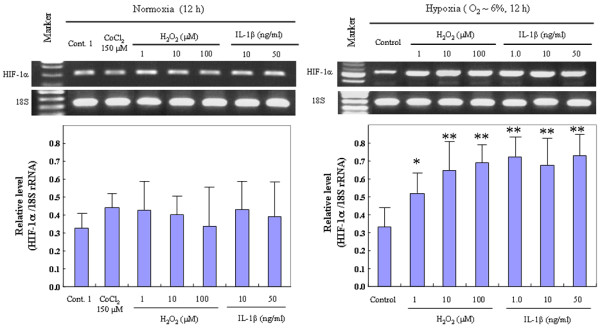
IL-1β and H2O2 induce the expression of HIF-1α mRNA in human articular chondrocytes. Under normoxic culture conditions, mRNA levels of hypoxia-inducible factor 1α (HIF-1α) were observed in cultured chondrocytes, whereas HIF-1α protein was undetected in the cells. HIF-1α mRNA was accelerated by IL-1β or H2O2 in cultured chondrocytes under hypoxic conditions. Cobalt chloride (CoCl2), chemical inducer of HIF-1, was used for the positive control. *P < 0.05, **P < 0.01 compared with the control. Cont., control.